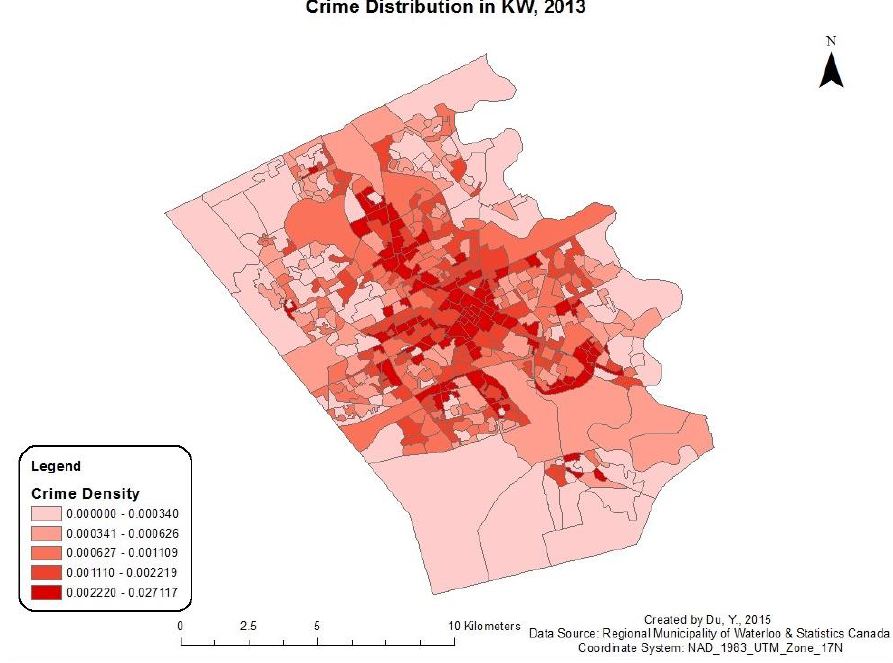
Figure 1. Crime distribution in the Kitchener-Waterloo region, 2013.